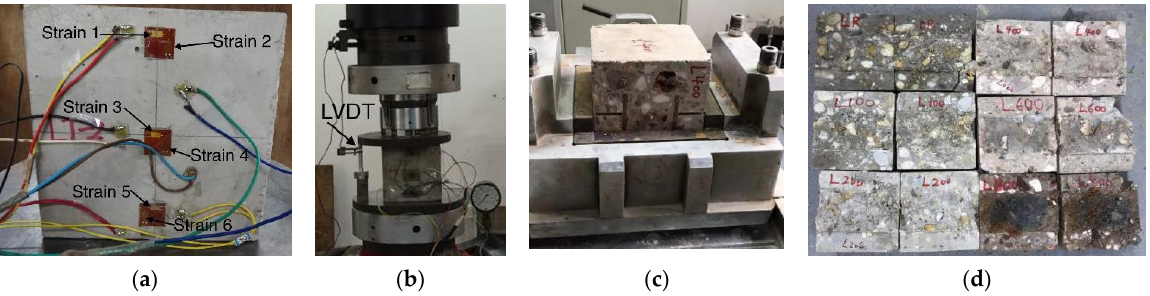
Figure 2. Photos of test detail: ( a ) location of strain gauges; ( b ) location of LVDT; ( c ) shear test; ( d ) failure specimens.